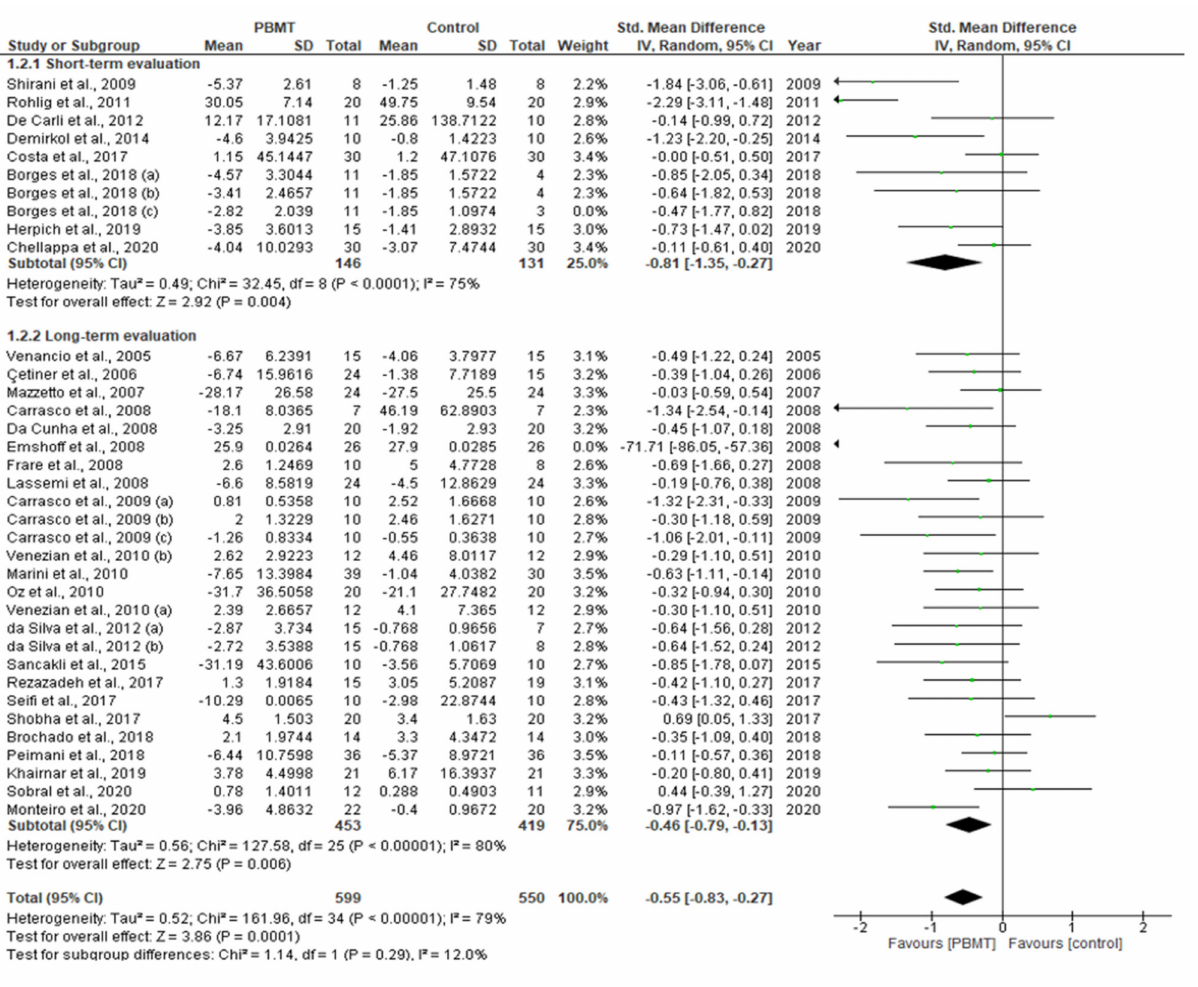
Figure 8. Forest plot with sub-group analysis for primary outcome qualitative pain reduction assessment (VAS score) from baseline up to the final follow-up